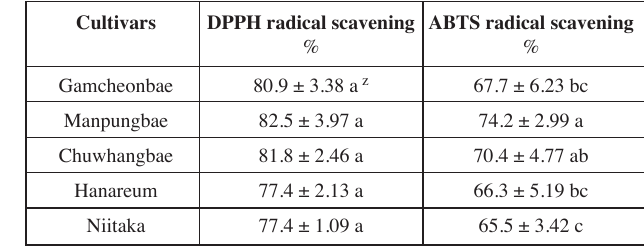
Tab. 1: Total phenolics, total flavonoids, and arbutin contents of five unripe pear cultivars. Cultivars